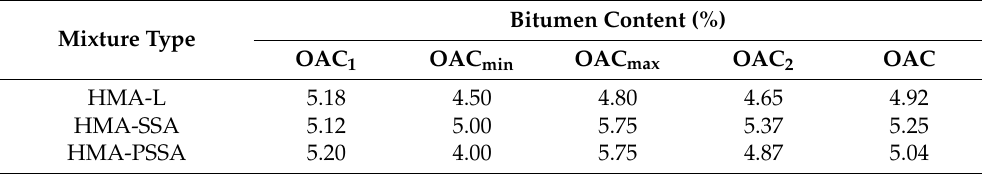
Table 8. OAC results for mixtures.